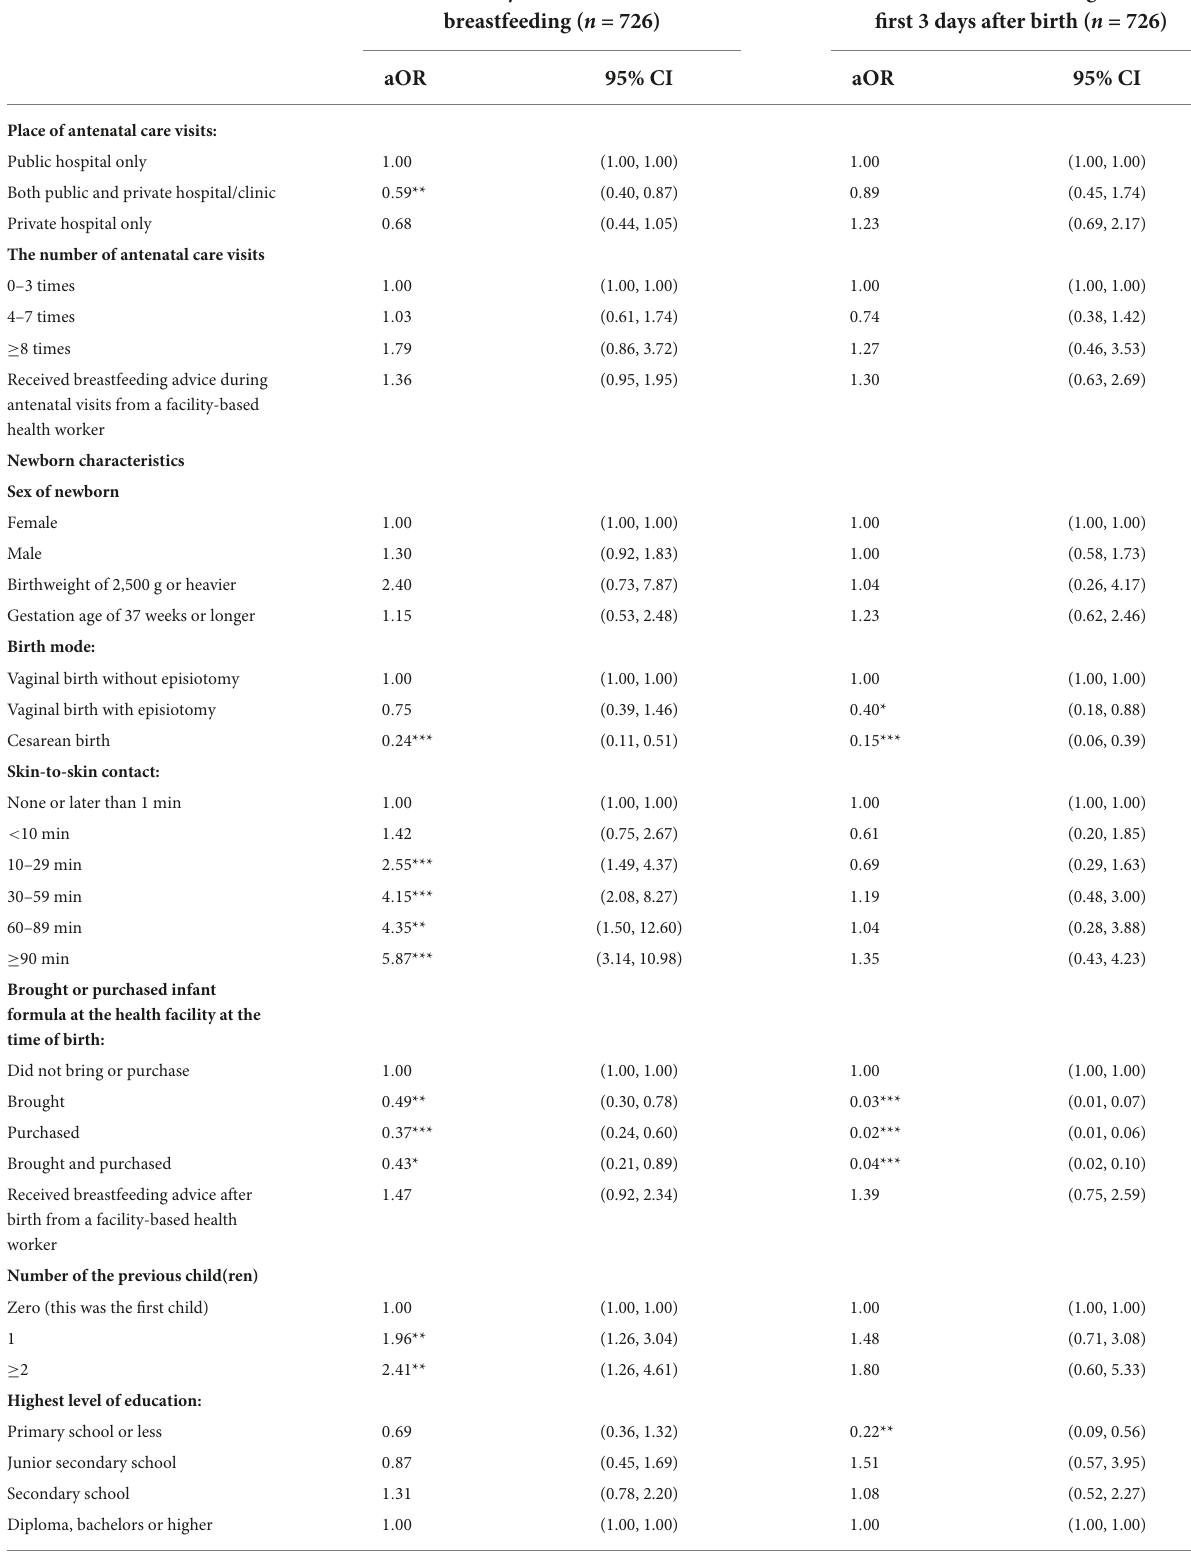
TABLE 5 Multinomial logistic regression analysis of the relationship between key variables and breastfeeding practices reported by mothers of infants 0–11 months, three provinces, Vietnam 2020 a